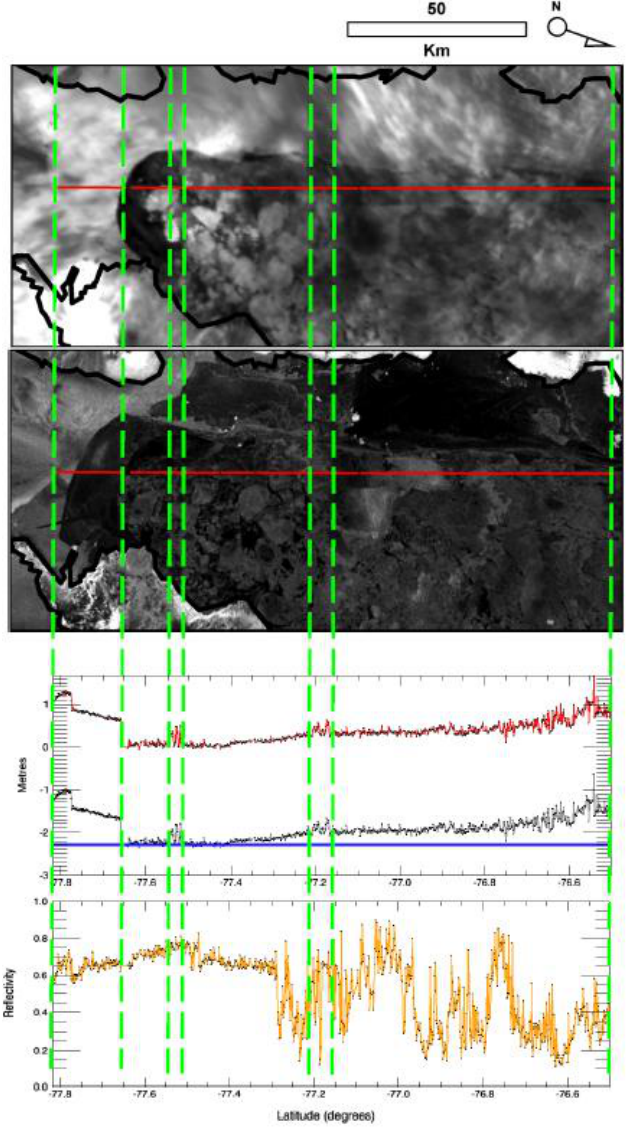
Figure 4. Near coincident ICESat altimetry/reflectivity (T = 16/11/2003 0900), Envisat ASAR (T -17 hours) and MODIS (T +5.5 hours) imagery. Black dots are shot locations. Metres axis, Fb (red), h (grey) and h s